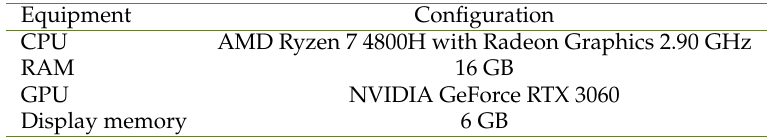
Table 1. Experimental hardware configuration.